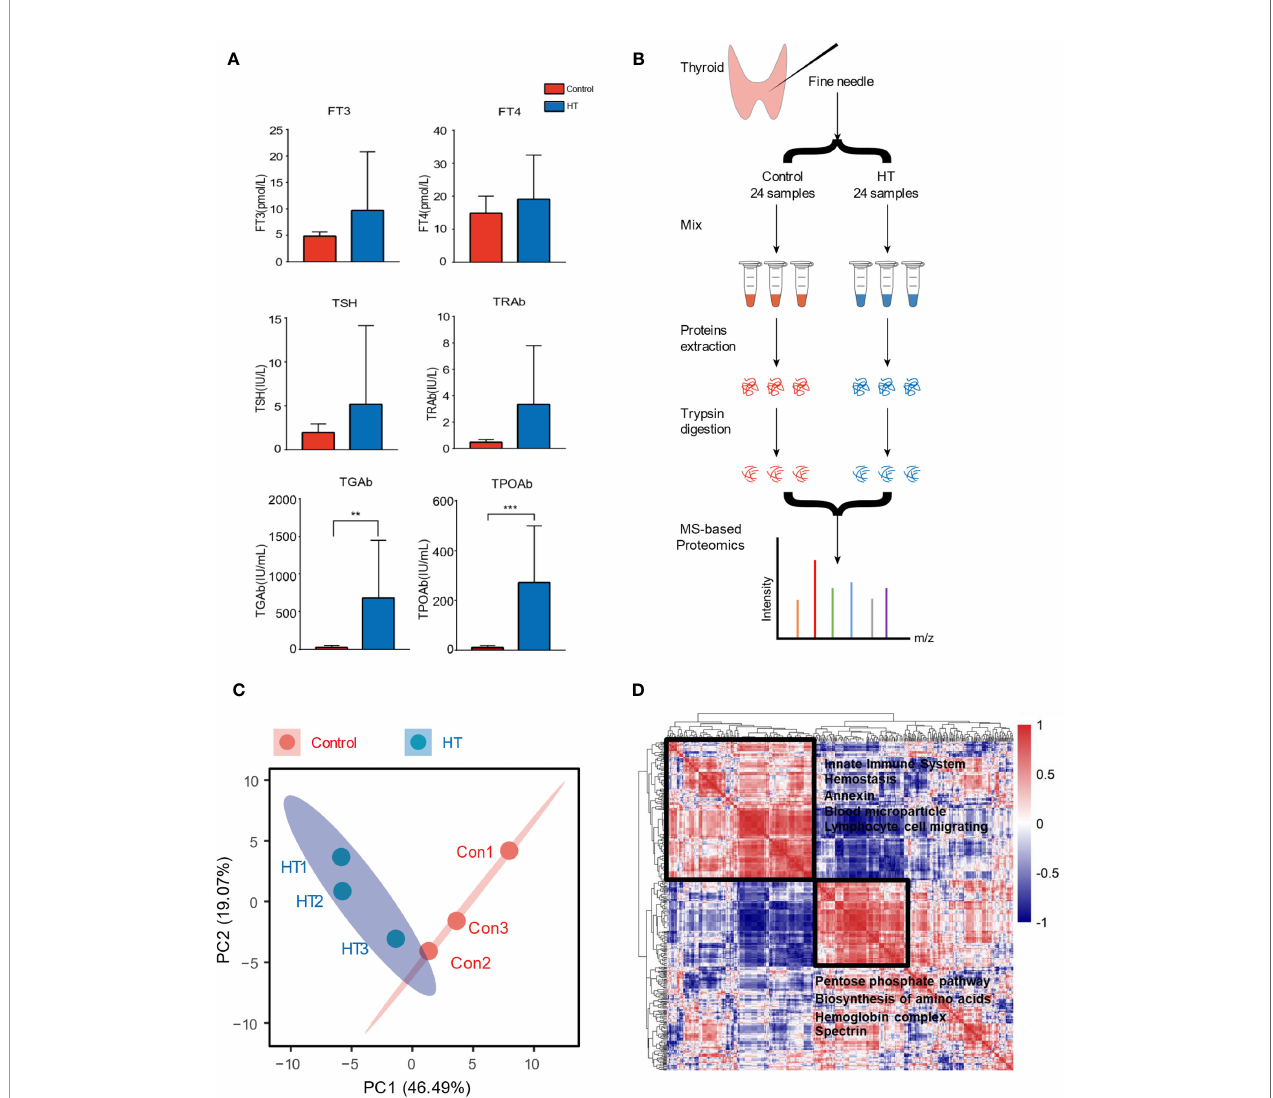
FIGURE 1 | Overview of sample preparation and result analysis presentation of proteomics. (A) Comparisonofantibody concentration inserum ofHashimoto ’ s thyroiditis (HT) andhealthycontrols. (B) Here, 24 patients and 24 healthypeoplewere divided into two groups, the samples were acquired by fi ne-needle aspiration, andeight samples were mixedinto one tube for subsequent mass spectrometry (MS). (C) Principal component analysis(PCA) biplot ofprotein concentration level; red dots represent the cluster Control, whileblue dots represent the cluster HT. The fi rst two axes accounted for 65% of variance. (D) Global correlation mapofproteins generated byclusteringthe Pearson correlation coef fi cients of allpossibleproteincombinations. The abundance of proteins with common regulation correlates across samples, and they therefore form a cluster. Prominent clustersare annotated with functional terms obtained from bioinformatics enrichment analysis. The inset shows the color code for Pearsoncorrelation coef fi cients. Error barsshow the mean±SEM.Asteriskssignifysigni fi cant differences using one-way ANOVA, ** P <0.01; *** P